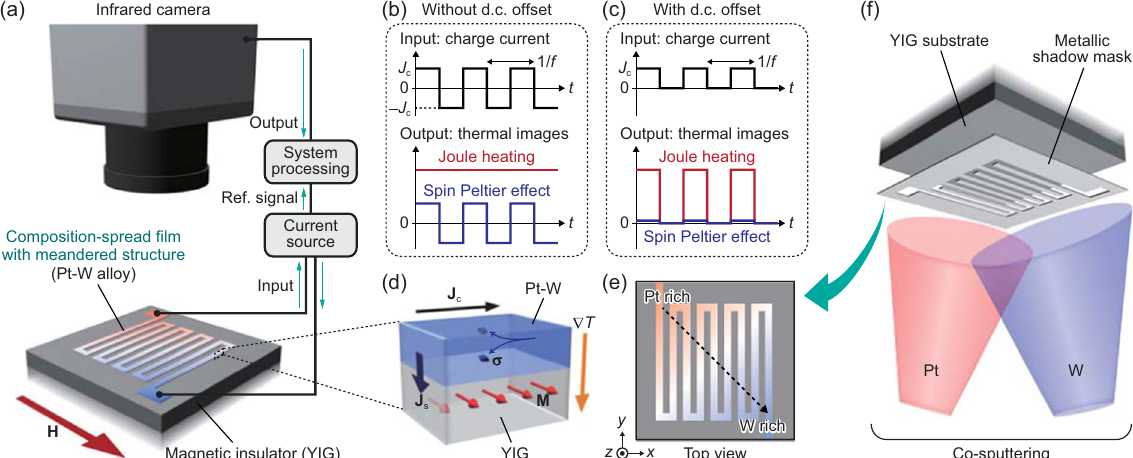
Figure 1. Combinatorial investigation of DSHE-driven SPE. ( a ) Schematic illustration of the LIT measurements and sample system used for measuring the SPE. The sample comprises a composition-spread Pt-W film with meandered structure formed on an YIG substrate. H denotes the magnetic field vector. ( b , c ) LIT conditions for the SPE ( b ) and Joule-heating ( c ) measurements. In the SPE (Joule-heating) measurements, a square-wave-modulated a.c. charge current with zero offset (finite d.c. offset J c /2), amplitude J c ( J c /2), and frequency f is applied to the Pt-W film. ( d ) The SPE induced by the DSHE near the Pt-W/YIG interface. M , J c , J s , and ∇ T denote the magnetization vector of YIG, charge current applied to the Pt-W film, spatial direction of the spin current with the spin-polarization vector σ generated by the DSHE in Pt-W, and temperature gradient appearing as a result of the SPE-induced heat current, respectively. ( e ) Schematic illustration of the Pt-W/YIG sample from a top view. ( f ) Schematic procedure for fabricating the composition-spread Pt-W film on the YIG